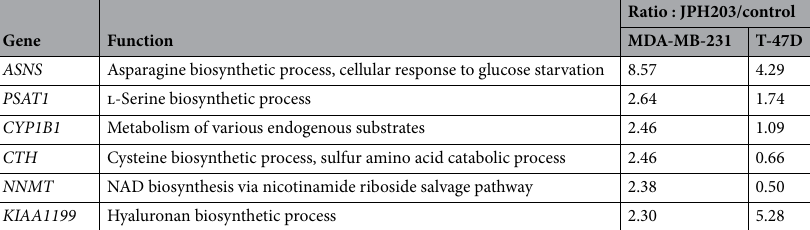
Table 1. Differentially expressed genes in MDA-MB-231 cells by JPH203